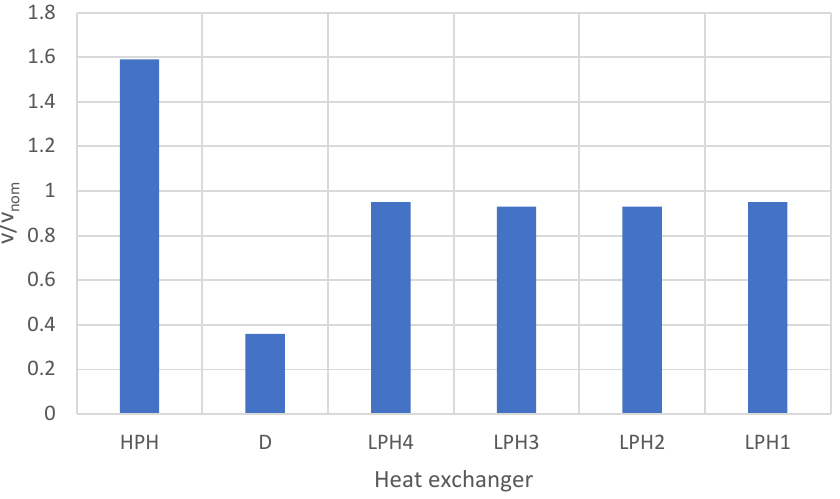
Figure 15. The velocity ratio of the steam flow in the pipeline to the heat exchangers (heat exchanger labels as shown in Figure 5).